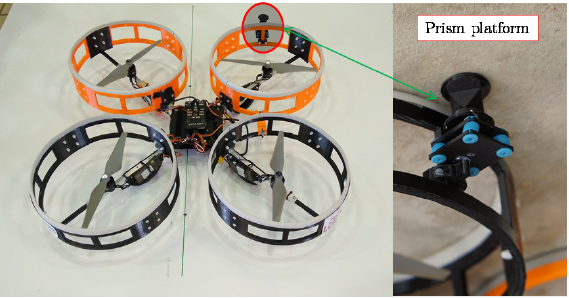
Figure 5. Final prototype of the platform and prism platform